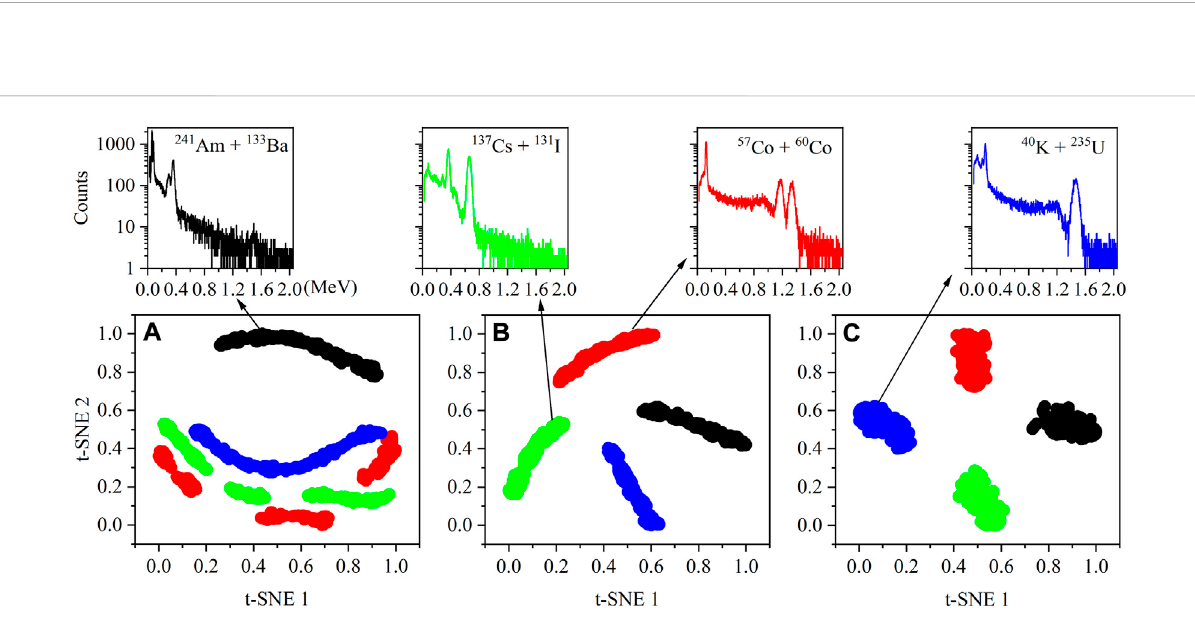
FIGURE 10 Results of feature visualization using t-SNT; (A) Visualization of the outputs of channel_maxpool in Table 2, (B) global_average_pooling1d in Table 2, (C) dense in Table